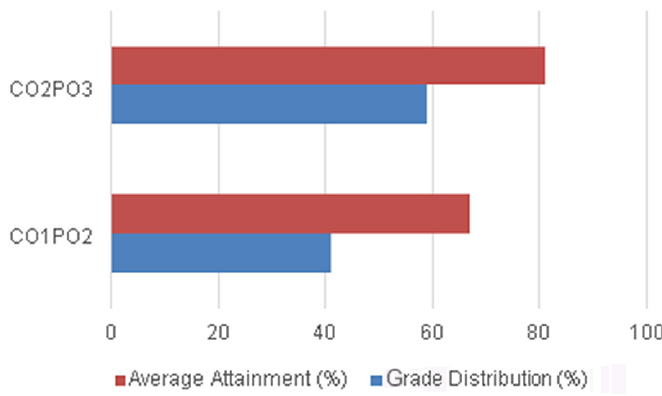
Fig. 4. COPO grade distribution and average